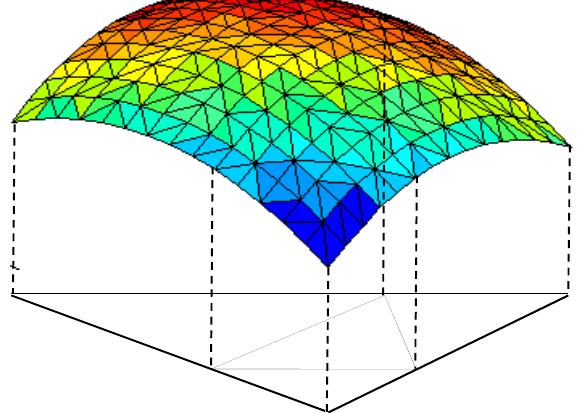
Figure 2. Quadratic Bézier Triangular Surface and Its Control Network Projection.